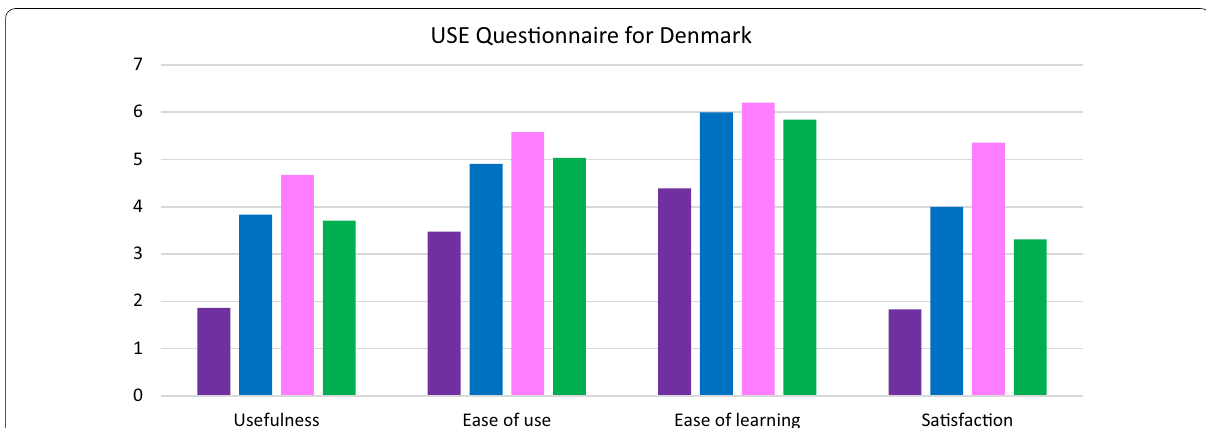
Fig. 3 The Pulso system. The Trilogis‑Monsenso. The Pulso wristband system. The Trilogis‑Monsenso wristband system. Patient‑based evaluation measured using the CSUQ questionnaire of the smartphone‑based self‑monitoring systems the Trilogis‑Monsenso system and the PULSO system and the two different wristband